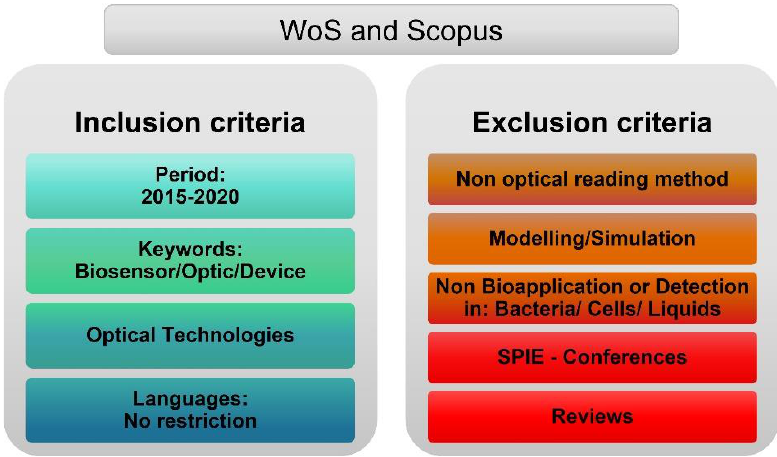
Figure 14. Inclusion – Exclusion Criteria (Web of Science and Scopus).